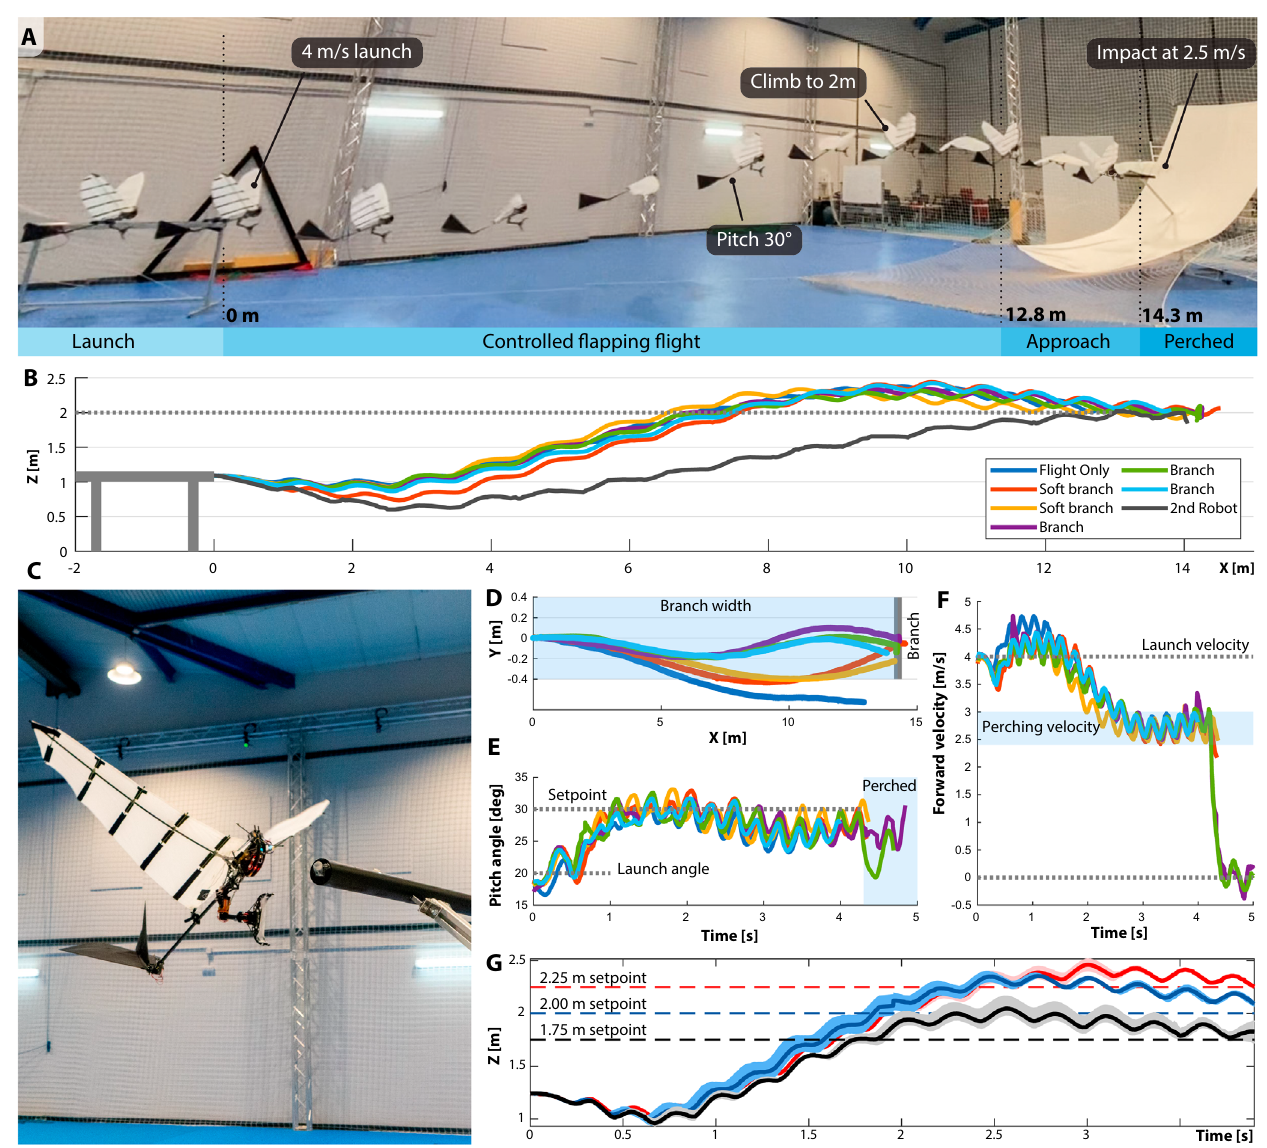
F Forward velocity of the robot, initially at 4m/s, was reduced to 2.5m/s at the branch location. The velocity measures do not fall to zero on impact, due to an automatic early end of the logging. G Altitude of the fl ight experiments with dif- ferent set points: blue color demonstrates fl ights targeting 2m height, red color 2.25m,andblackcolor1.75m.Theplotsshowthemeanvalueandvarianceof3sets of fl